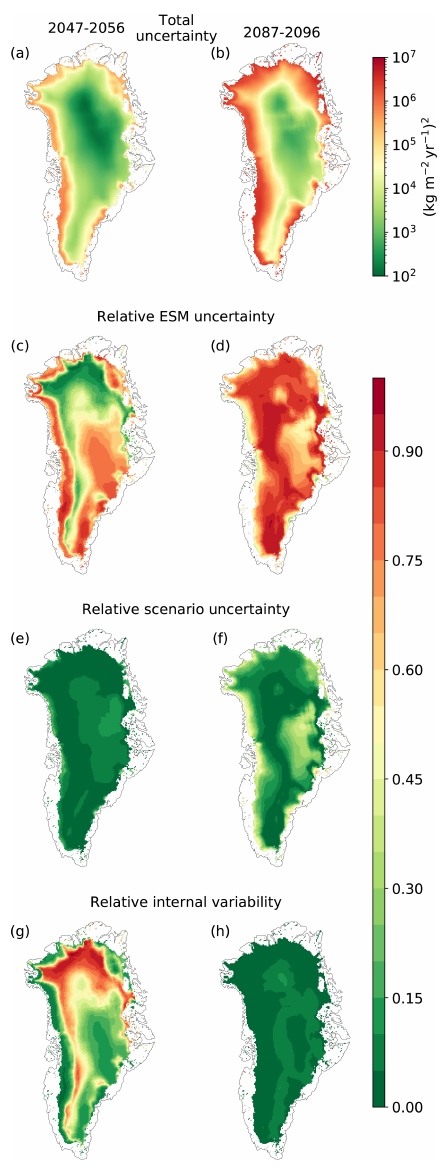
Figure 6. (a, b) Total variance, consisting of ESM uncertainty, sce- nario uncertainty, snow model parameter uncertainty, and internal variability. (c, d) Ratio of ESM uncertainty and sum of the uncer- tainties. (e, f) Ratio of scenario uncertainty and sum of the uncer- tainties. (g, h) Ratio of internal variability and sum of the uncertain- ties. Panels (a, c, e, g) show the mean over the years 2047–2056, panels (b, d, f, h) show the mean over the years 2087–2096. The latter is the last decade that the variance splitting approach is valid for because it is applied to the decadal running mean of the yearly SMB. The years 2047–2056 are chosen as a decade in the middle of the 21st